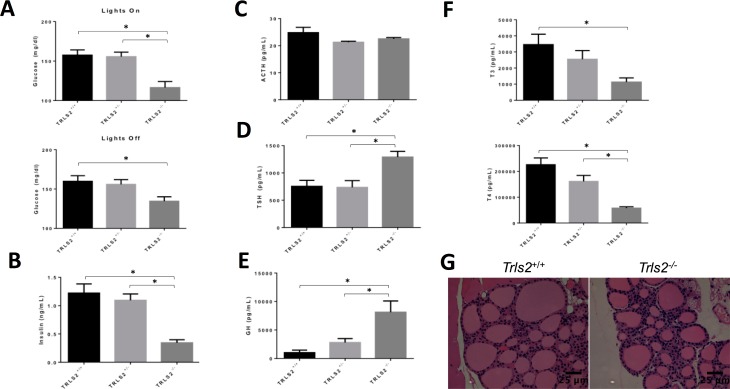
TRLS2-/- mice demonstrate appropriate hormone responses to low blood glucose.A) Blood glucose was assessed at two time points in Trls2+/+, Trls2+/-, and Trls2-/- mice, one hour after lights on (top graph) and an hour after lights off (bottom graph). Trls2-/- mice show significantly lower blood glucose at both time points (One-Way ANOVA. Lights On: F(2,33) = 11.79, p < 0.0001. Lights Off: F(2,33) = 4.626, p < 0.05. Tukey’s Post Hoc Test p < 0.05). B)
Trls2-/- mice have significantly less serum insulin at one hour after lights off (One-Way ANOVA. F(2,30) = 13.72, p < 0.0001. Tukey’s Post Hoc Test p < 0.05). C) Serum ACTH levels are similar between Trls2+/+, Trls2+/-, and Trls2-/- mice. D) Serum TSH (One-Way ANOVA. F(2,33) = 7.739, p < 0.01. Tukey’s Post Hoc Test p < 0.05). and E) GH (One-Way ANOVA. F(2,31) = 9.103, p < 0.001. Tukey’s Post Hoc Test p < 0.05) are increased Trls2-/- mice. F) T3 (top graph; One-Way ANOVA. F(2,28) = 5.699, p < 0.01. Tukey’s Post Hoc Test p < 0.05) and T4 (bottom graph; One-Way ANOVA. F(2,32) = 17.96, p < 0.0001. Tukey’s Post Hoc Test p < 0.05) are decreased in Trls2-/- mice. G) H&E sections (40x) of thyroid gland morphology is similar between Trls2+/+ and Trls2-/-, without signs of swollen follicles or dysplastic epithelial cells. Significance (p < 0.05) is denoted with an *, and error bars represent Standard Error of the Mean. (n+/+ = 10–12, n+/- = 10–12, n-/- = 10–12).